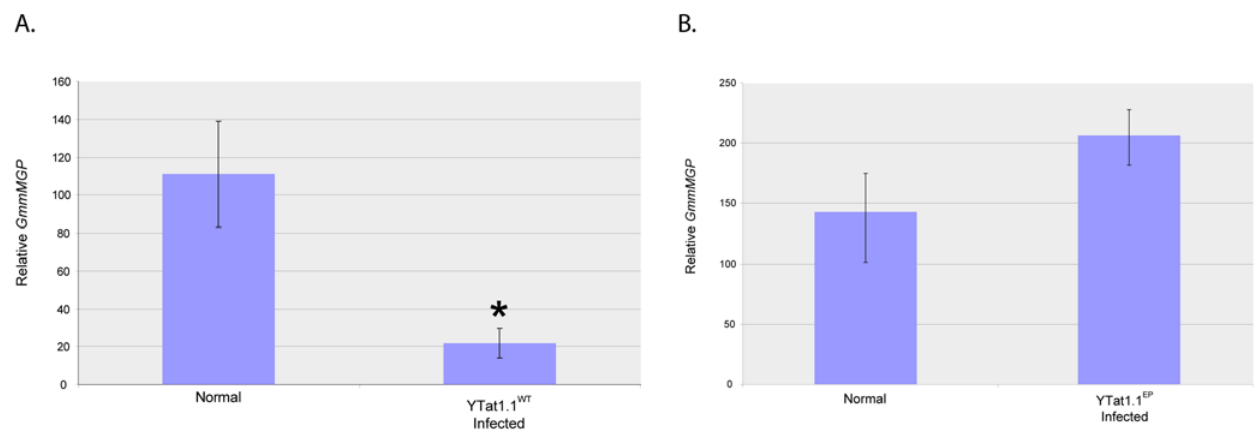
Figure 4. qRT-PCR expression analysis of the major milk gland protein GmmMGP from YTat1.1 WT infected and age-matched uninfected controls (A) and YTat1.1 EP infected and age-matched uninfected controls (B). The bars denote standard error values observed among eight individuals tested in each group. The * denotes significant difference from control P , 0.05.